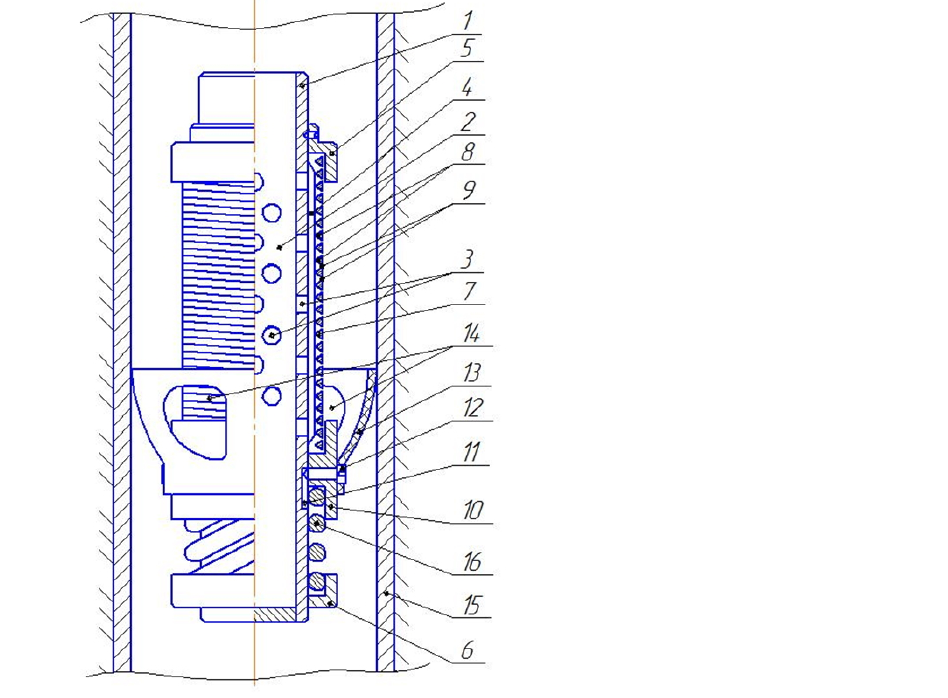
Figure 4. Scheme of the borehole slotted self-cleaning filter with deformable filter element.